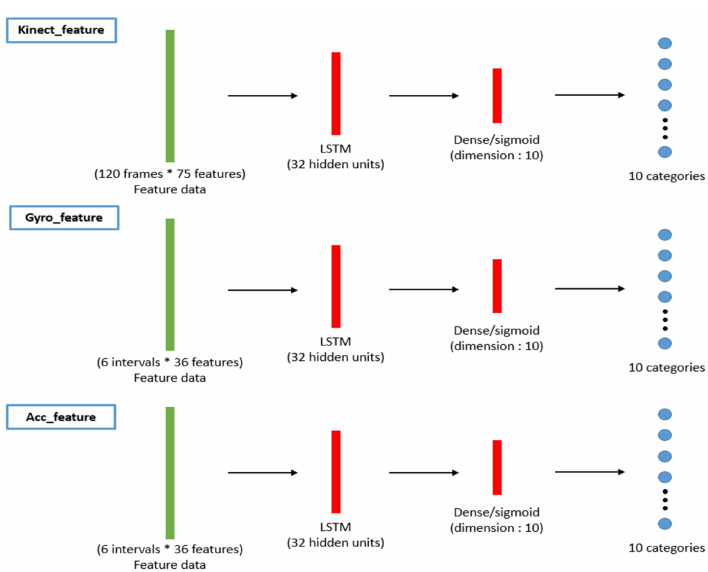
Figure 8. Training process for the behavior classifiers of the proposed LSTM-based